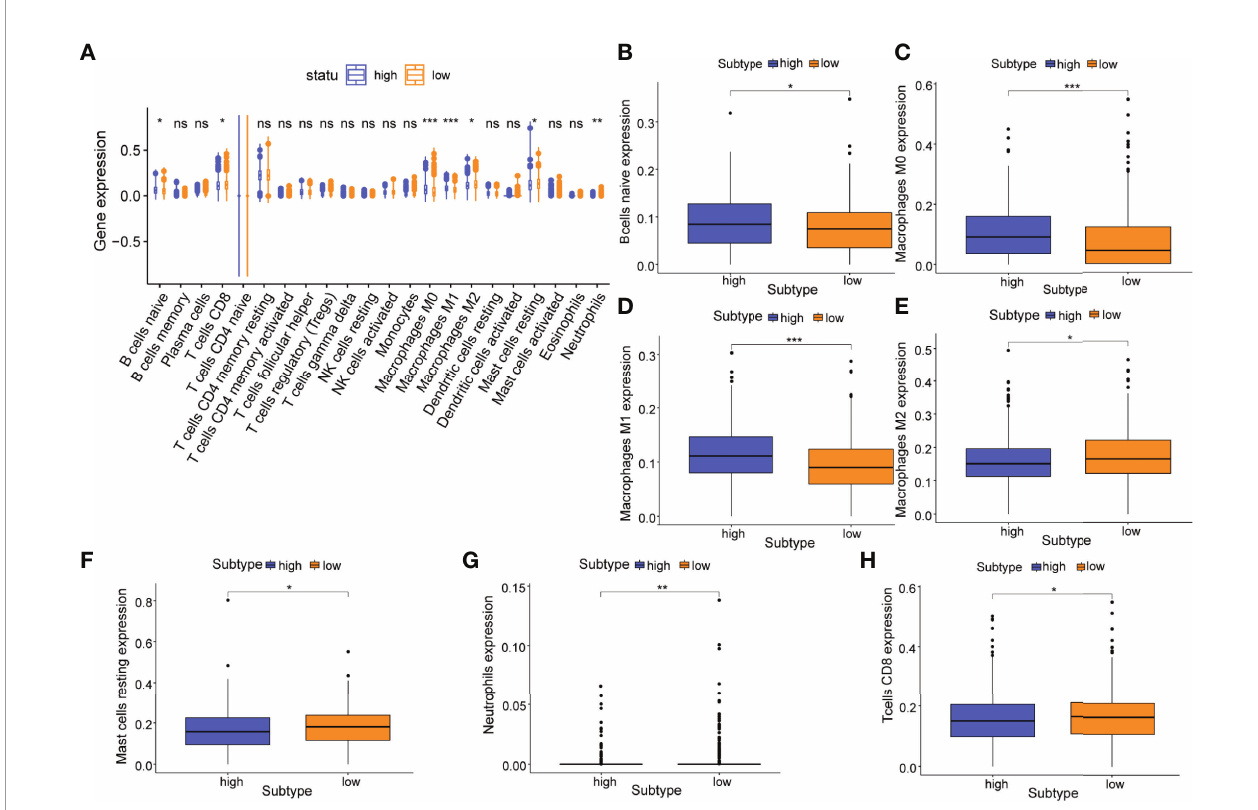
FIGURE 6 | Relationship of the m5C prognostic model and tumor immune in fi ltration. (A) Differences in the abundance of 22 in fi ltrating immune cell phenotypes in high-risk and low-risk subtypes. Differences in the abundance of 7 in fi ltrating immune cell phenotypes including (B) naive B cells; (C) M0 macrophages; (D) M1 macrophages; (E) M1 macrophages; (F) resting mast cells; (G) neutrophils, and (H) CD8+ T cells in high-risk and low-risk subtypes. P-values were shown as follows: ns, not signi fi cant, * P < 0.05; ** P < 0.01; *** P <